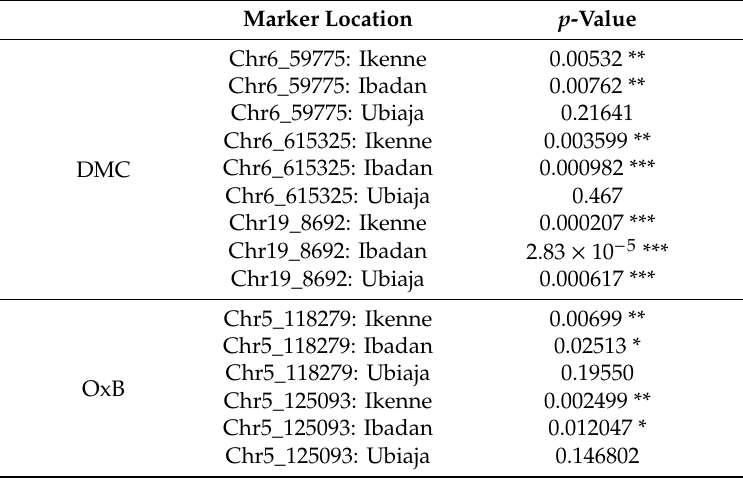
Table 5. QTL interaction across each location.